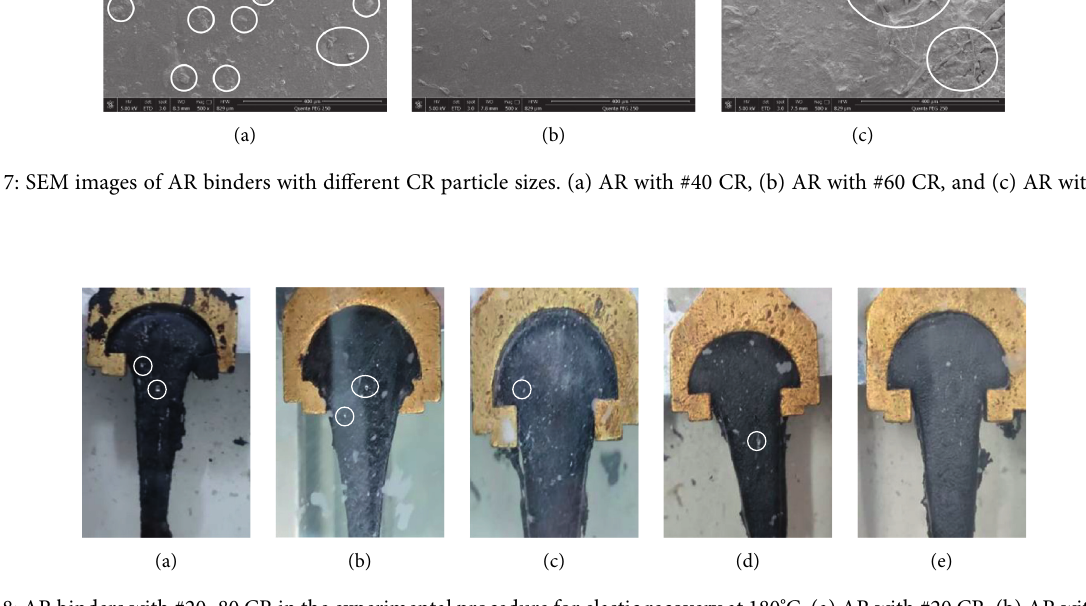
Figure 8: AR binders with #20–80 CR in the experimental procedure for elastic recovery at 180 ° C. (a) AR with #20 CR, (b) AR with #30 CR, (c) AR with #40 CR, (d) AR with #60 CR, and (e) AR with #80 CR.